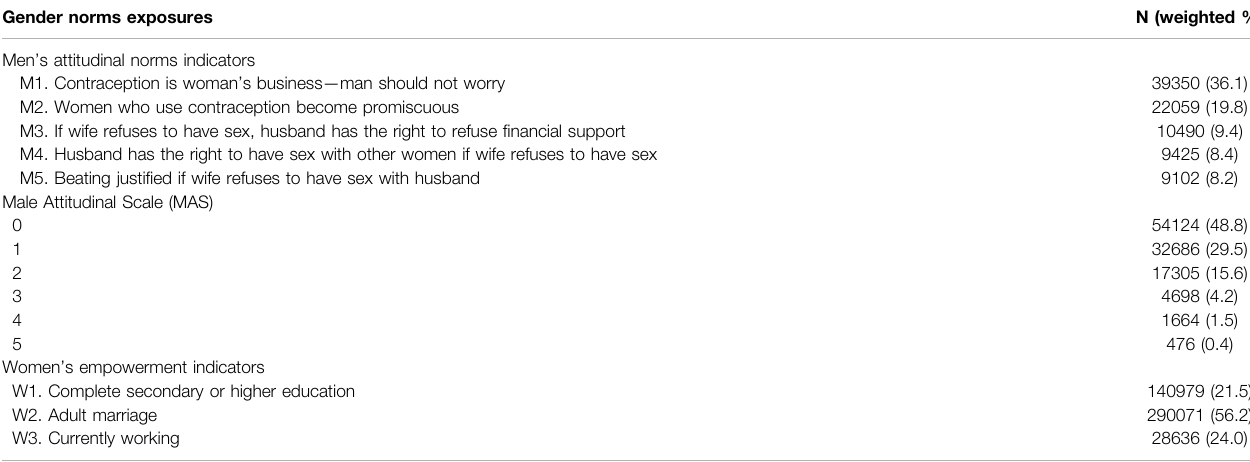
TABLE 2 | Sample size, and attitudinal (men aged 15 – 54) and empowerment (women aged 15 – 49) norms at the district level, NFHS-4. Gender norms exposures N (weighted